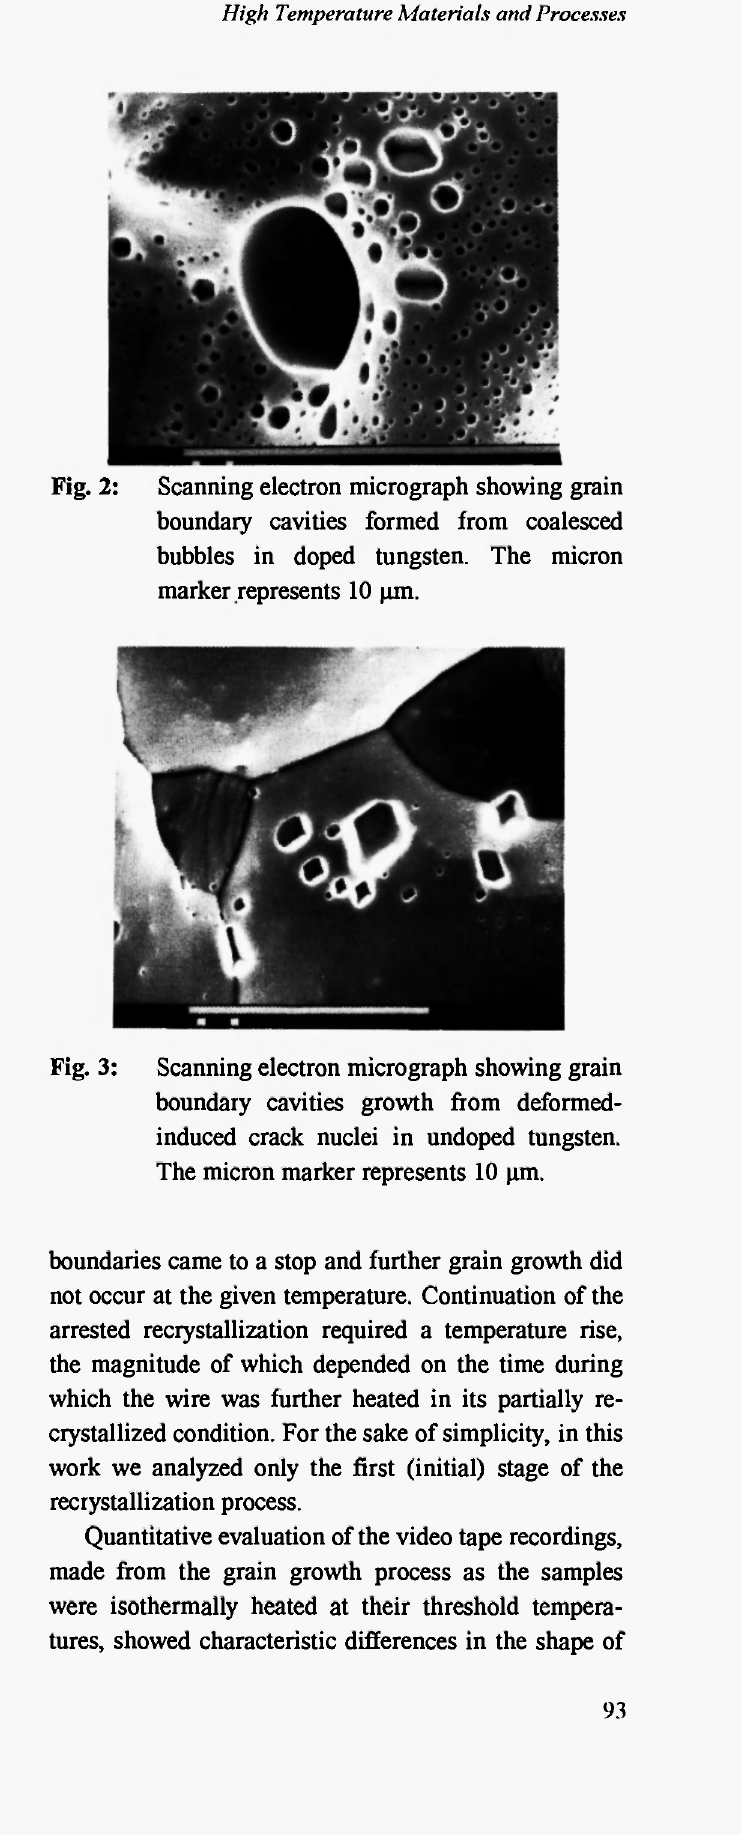
Fig. 2: Scanning electron micrograph showing grain boundary cavities formed from coalesced bubbles in doped tungsten. The micron marker represents 10 μτη.